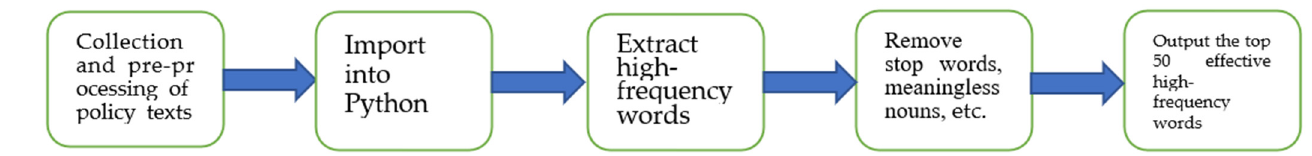
Figure 1. Process of high-frequency words’ statistics.